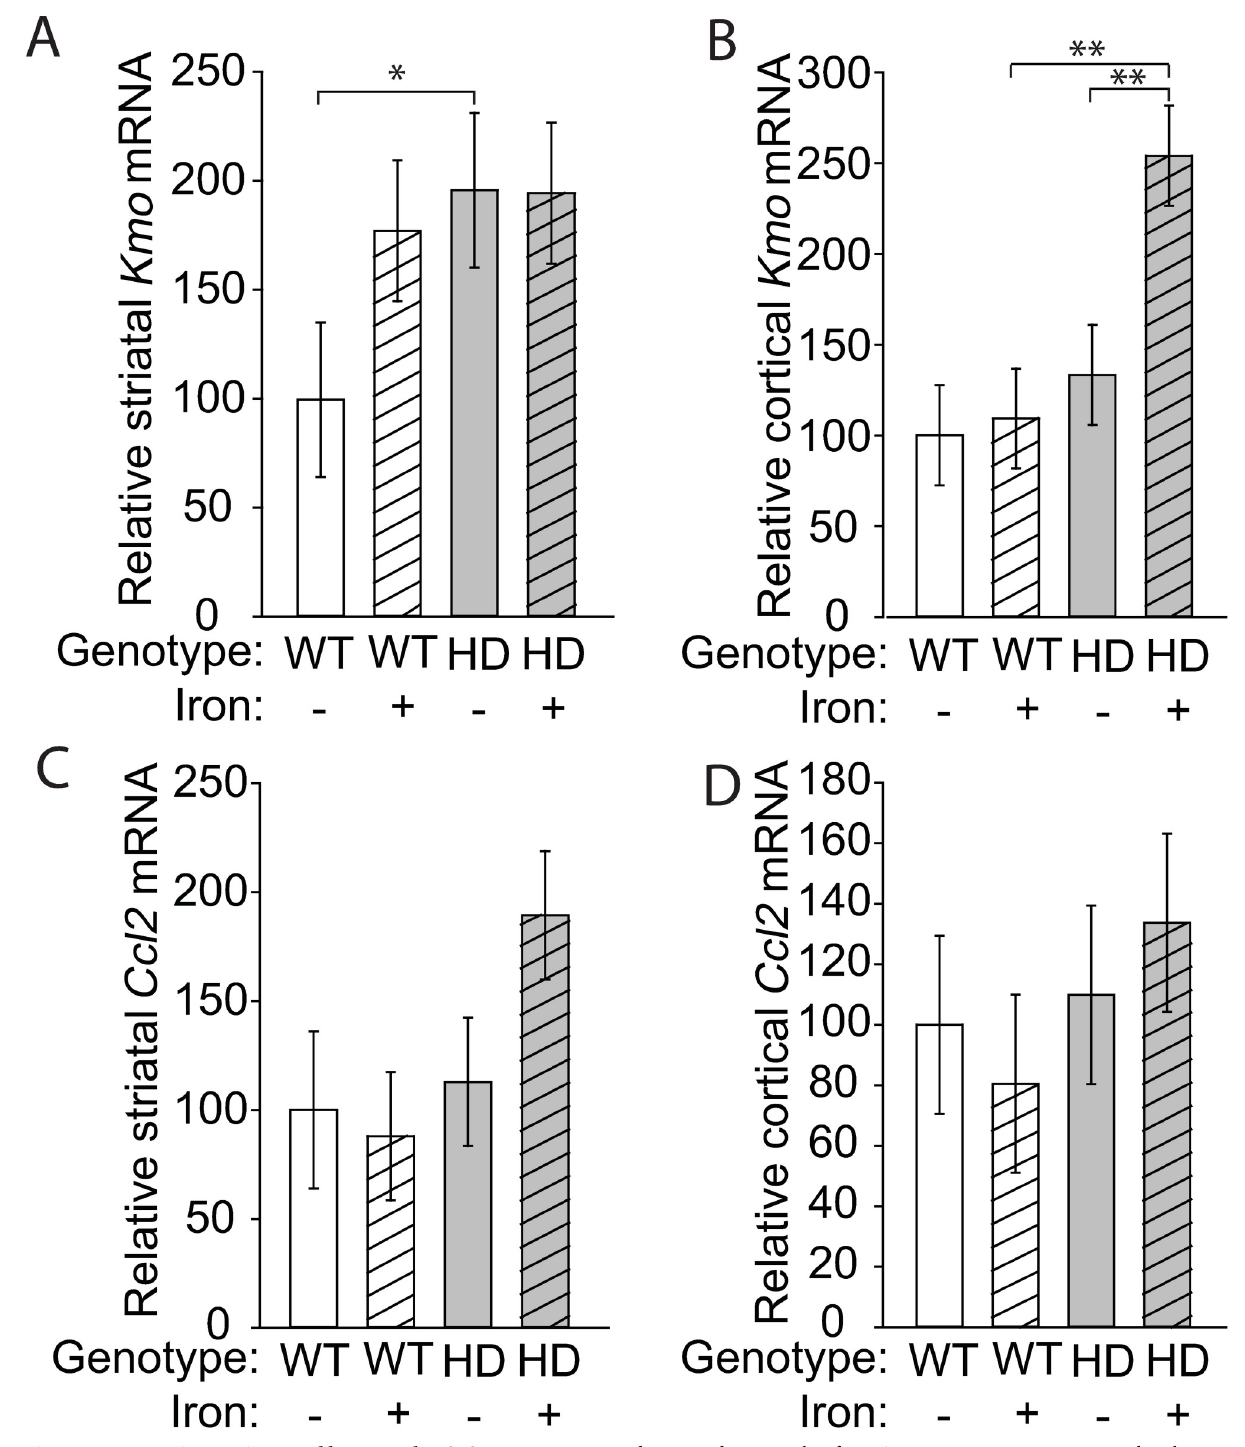
Fig 6. Kmo transcripts are increased by HD and NIS. Gene expression was determined at 14 weeks of age. A . Kmo expression was increased in the mouse HD striatum relative to WT but NIS had not effect. B. Kmo expression in iron-supplemented HD mice was significantly increased in the cortex. C-D . Ccl2 expression was unchanged in the striatum ( C ) and cortex ( D ). n = 6.Data are shown as the mean ± SE. � p < 0.05.